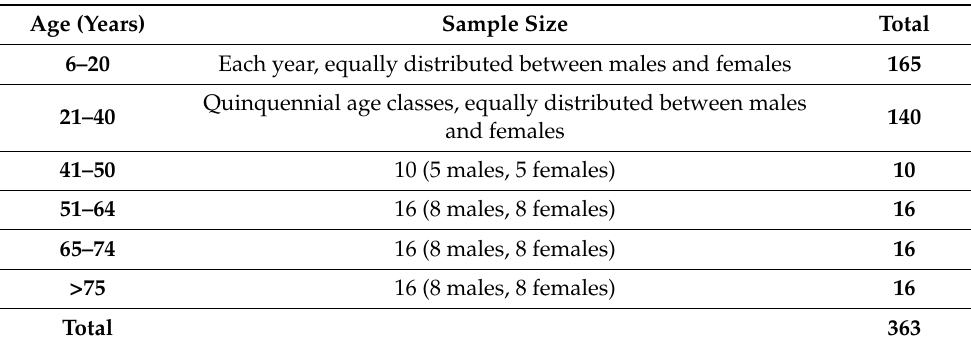
Table 1. Sample size for each